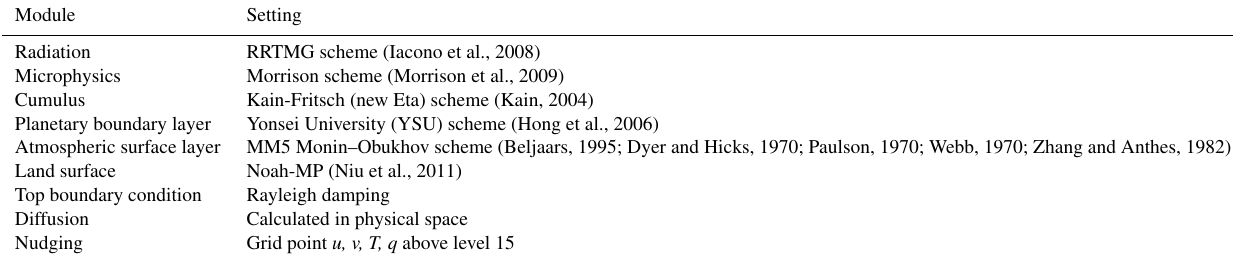
Table 1. Physics modules and assumptions used in WRF. Module